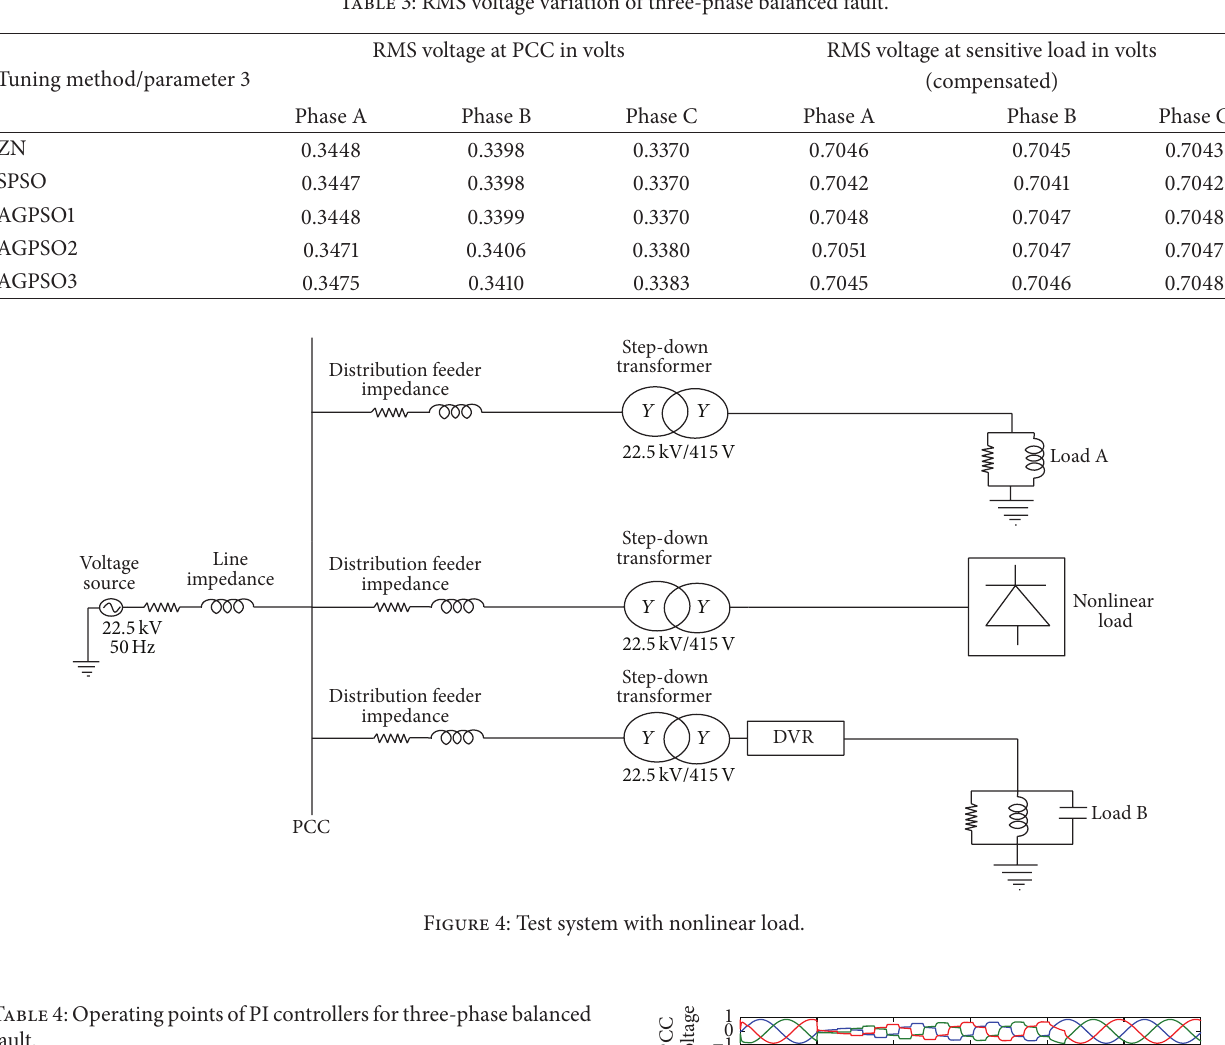
Table 3: RMS voltage variation of three-phase balanced fault.